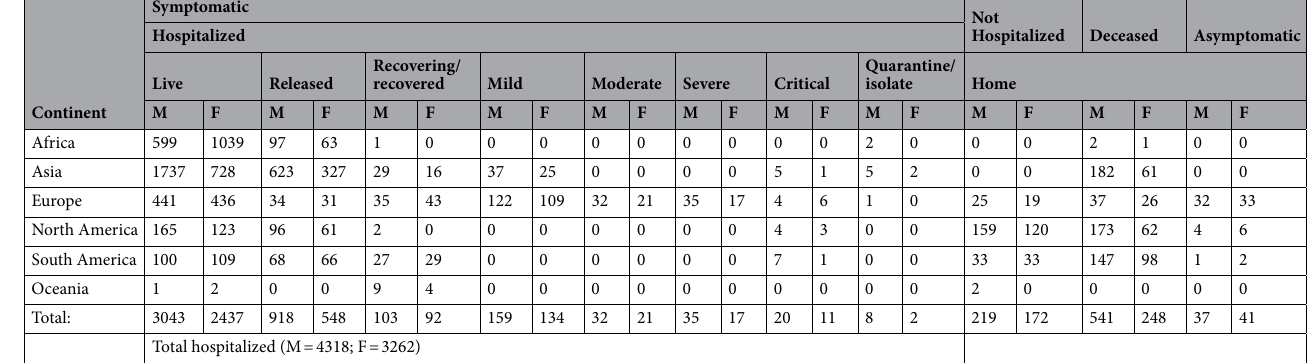
Table 10. Symptomatic and asymptomatic